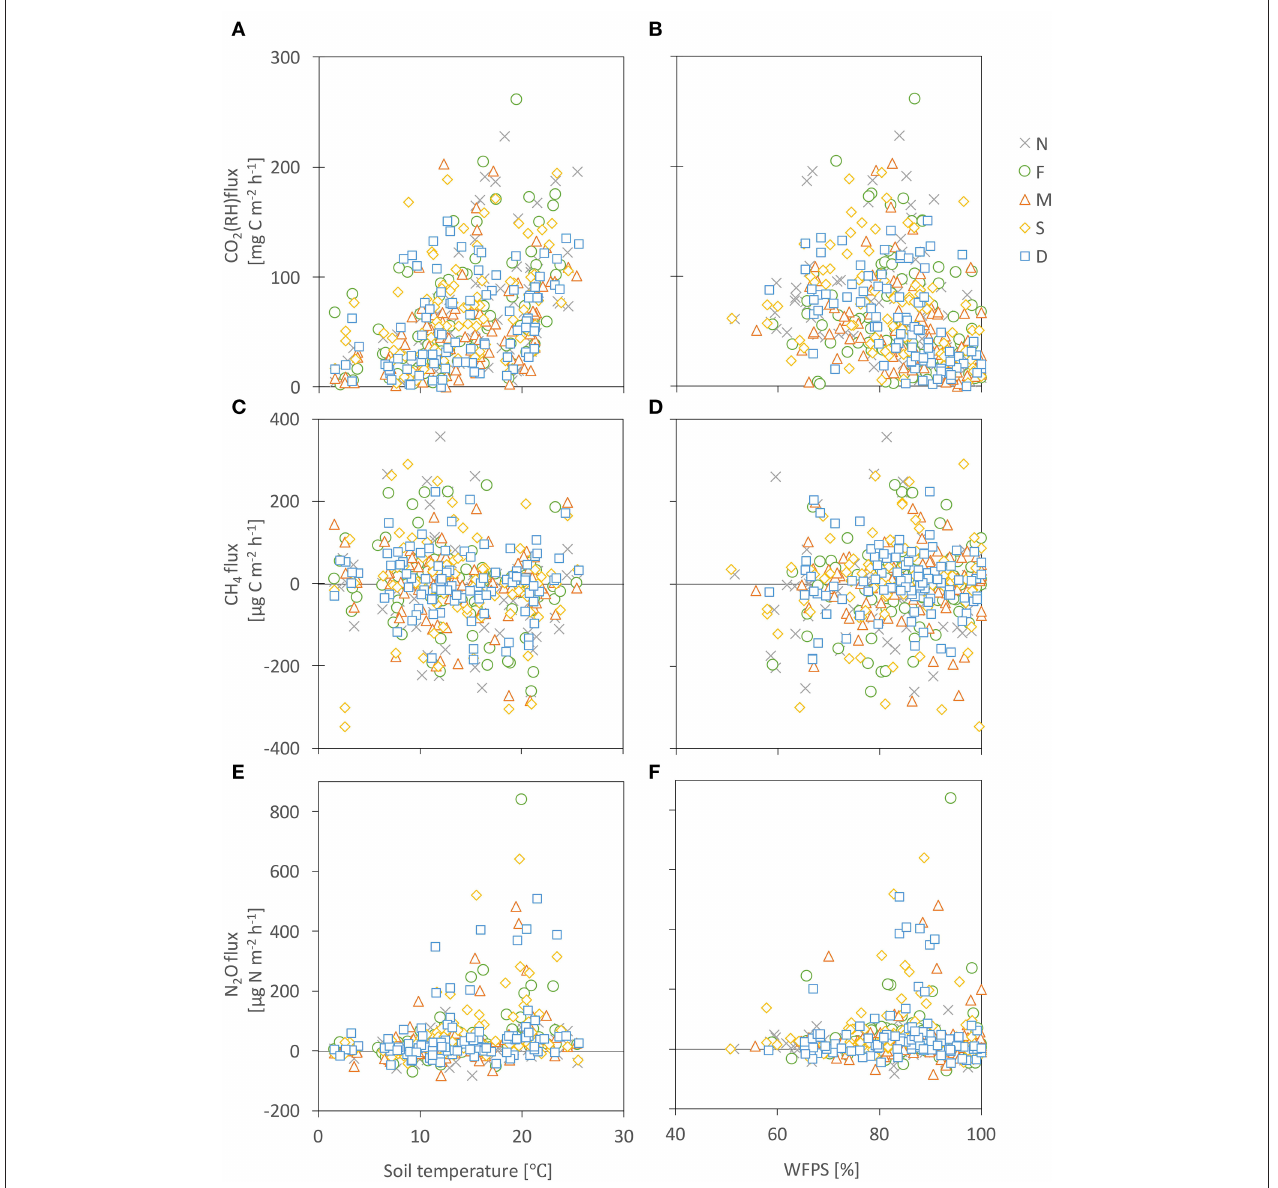
FIGURE 4 | Relationship between CO 2 (RH) flux and soil temperature (A) and WFPS (B) , CH 4 flux and soil temperature (C) , and WFPS (D) , and N 2 O flux and soil temperature (E) and WFPS (F) . N is the no fertilizer plot, F is the chemical fertilizer plot, M is the manure plot, S is the slurry plot, and D is the digestive fluid